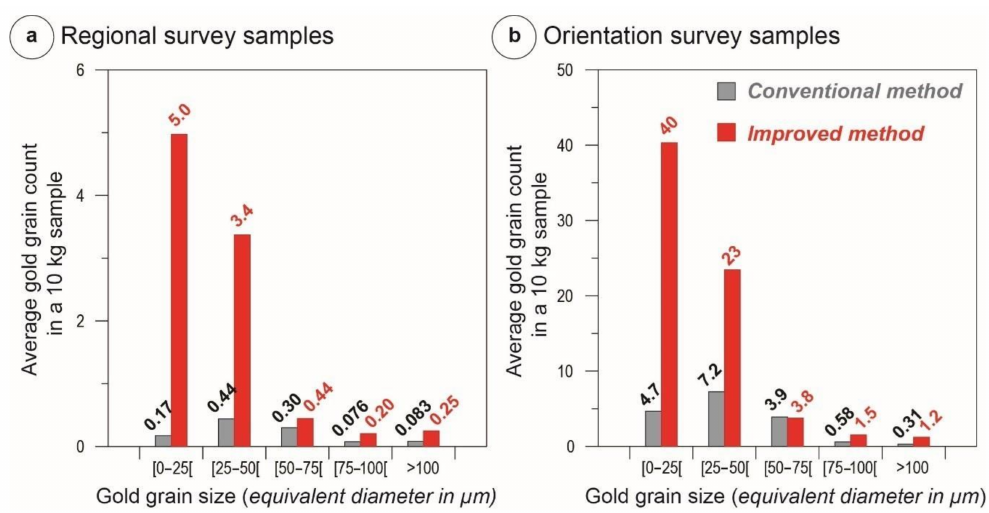
Figure 10. Comparison of the size distribution of the average gold grain count in a 10 kg ( − 1 mm) sample for the conventional and improved methods. Gold grain size distribution of ( a ) regional till samples and ( b ) orientation till samples collected around the Borden gold deposit. See the text for further details. It should be noted that the vertical scale for the orientation samples ( b ) is 8.3 × the vertical scale of the regional samples ( a